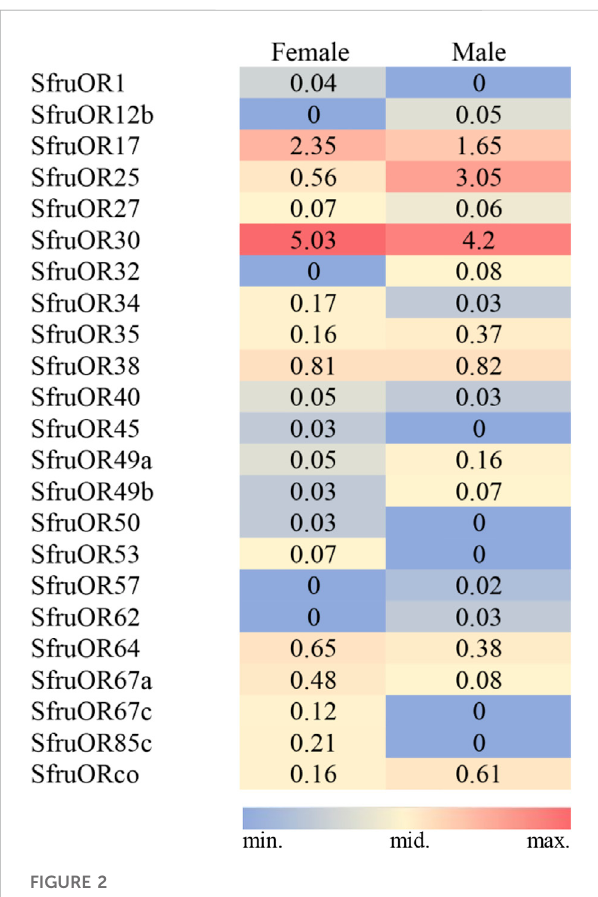
Prism 6 (GraphPad Software Inc., San Diego, CA, United States). The level of signi fi cance was set at p < 0.05.